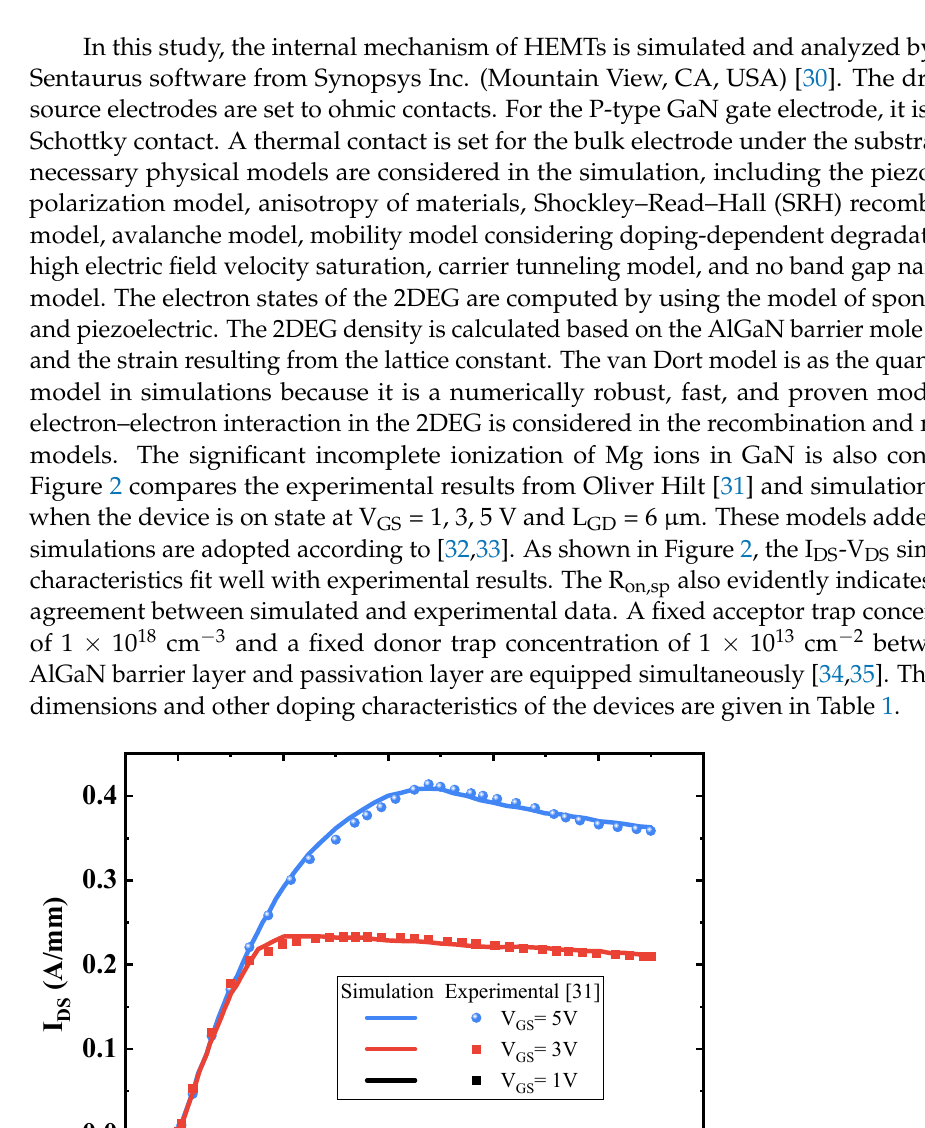
Figure 1. Schematic cross-section of the ( a ) Con-HEMT, ( b ) DC-HEMT, and ( c ) proposed buried Si 3 N 4 passivation layer GaN HEMT (BP-HEMT).